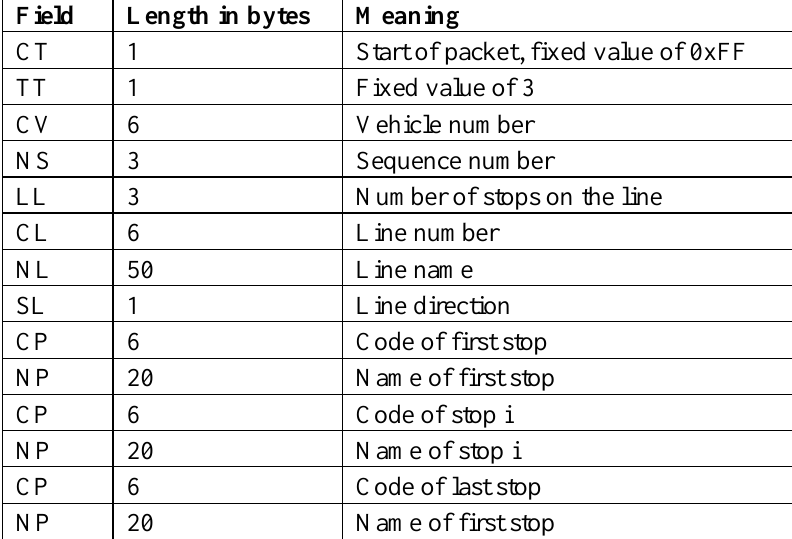
Table 7. Datagram